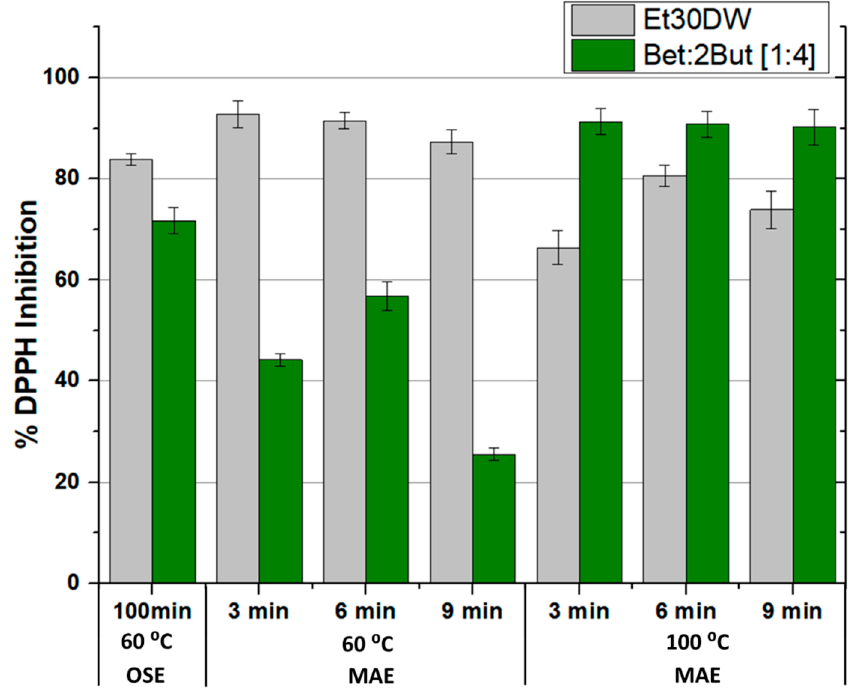
Figure 4. Phenolic compounds extracted according to the orbital shaker extraction (OSE) or micro- wave-assisted extraction (MAE) method used and as a function of the evaluated solvent (Et30DW or Bet: 2But [1:4]). Results are expressed as mean values (mg phenolic compounds/g WGW) ± RSD (%).